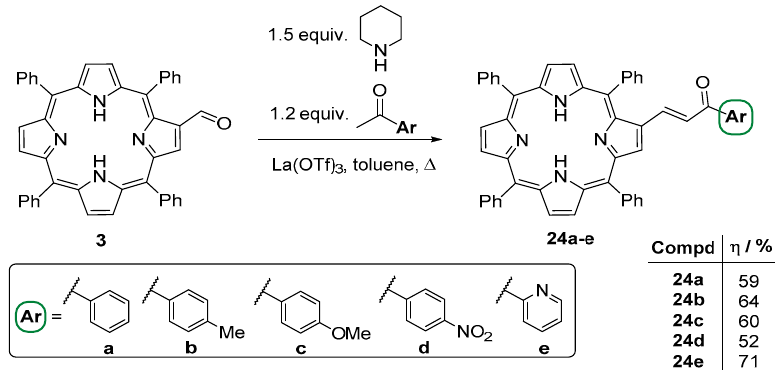
Figure 9. Other products obtained in the condensation of β -CHOTPP with acetylpyridines